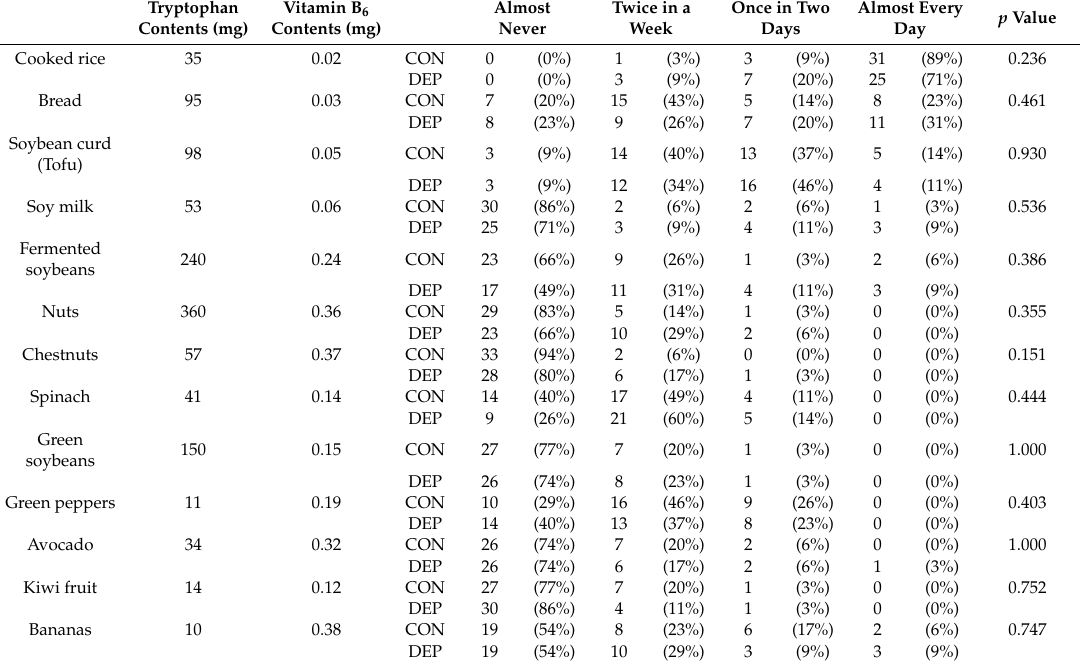
Table 2. Weekly frequency of intake of food items rich in tryptophan and vitamin B 6 and their contents per 100 g of